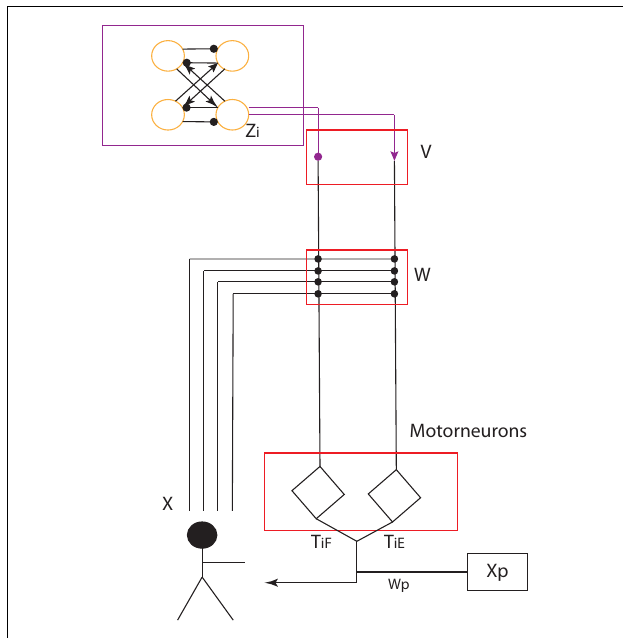
FIGURE 2 | CPG controller (Top: the four-cell network) and its layered structure. Yellow circles represent a coupled RG group corresponding to yellow area in Figure 1 .The round-headed and sharp-headed arrows represent negative ( − 1) and positive ( + 1) connection weights (for details, please refer to text.)The four-cell network (purple-framed area) fulfills the function of the PF layer.The two diamonds represent the motorneuron layer which integrates sensory feedback and upper-layer outputs. V , W , W p are weight vectors which integrate PF-layer outputs, sensory feedback and posture control terms respectively. T Ei and T Fi are the strength weights of extensor and flexor.